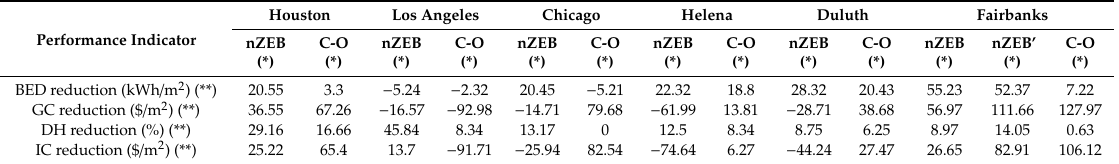
Table 15. Comparison between the proposed optimal solutions and the related reference